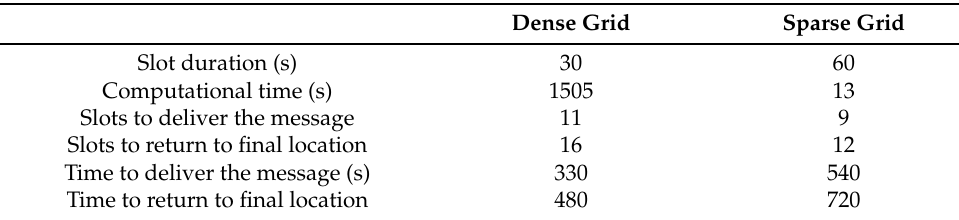
Table 2. Computational vs. delivery time.